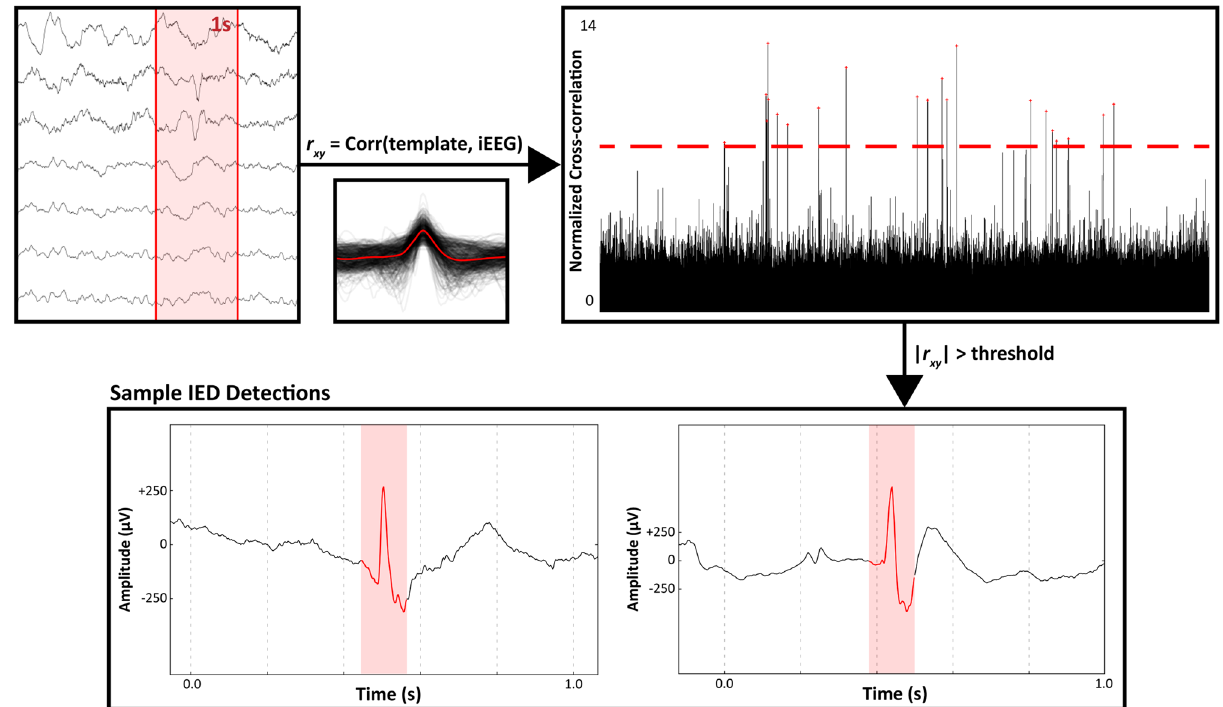
Figure 1. Automated spike detector pipeline. A template-matching IED detector first cross-correlated a 60-ms triangular template with preprocessed Stereo-EEG, then normalized the cross-correlation by the median standard deviation from 1-s sliding windows. The absolute value of the normalized cross-correlation was then used to mark local peaks above a specified threshold as